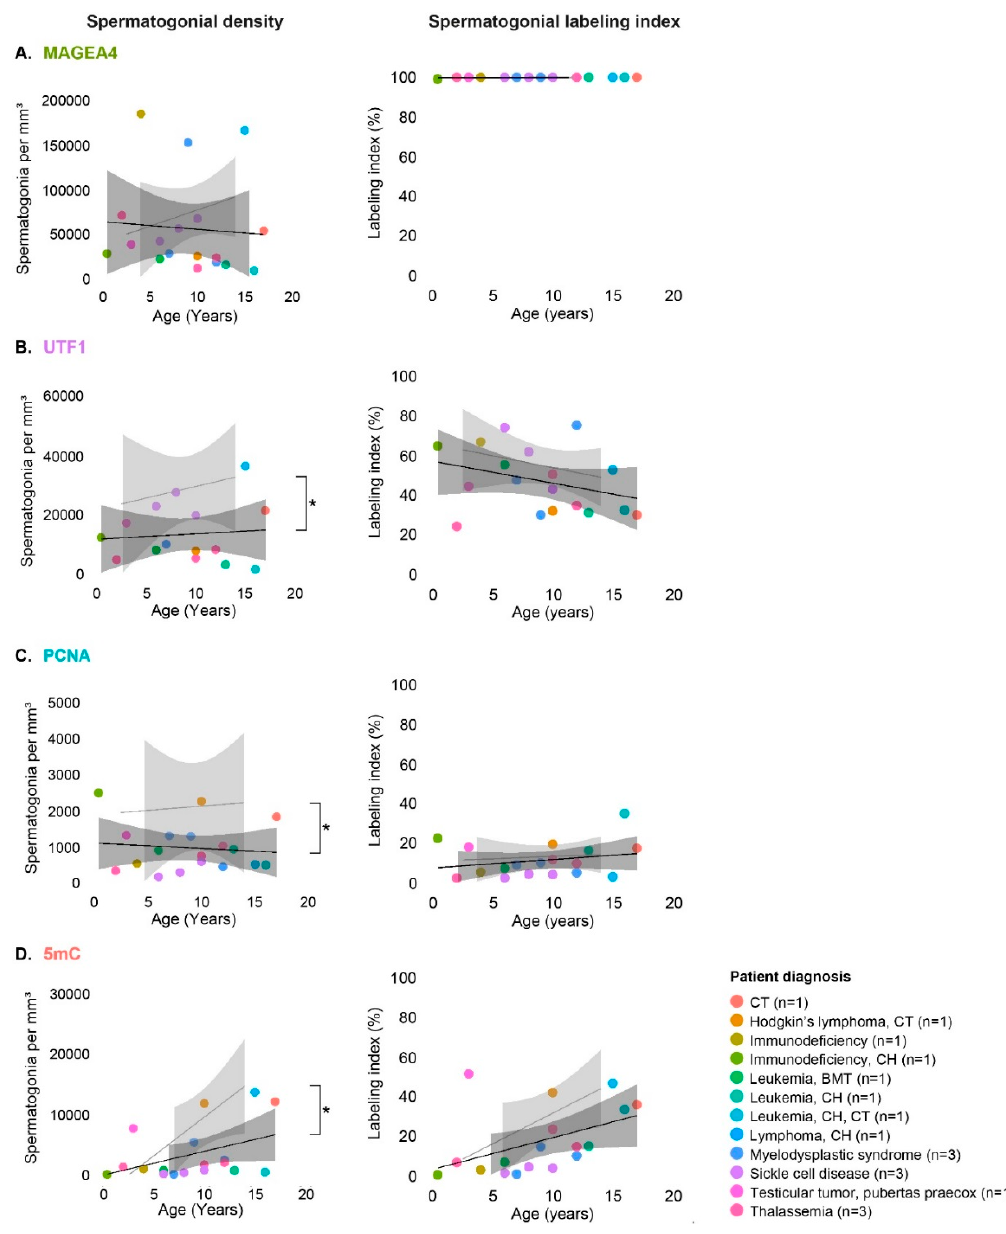
Figure 4. Spermatogonial density and labeling indices (%) of patients with potentially affected tissue by disease and / or treatment (AT group) compared with established values during normal testicular development (NT group). ( A ) MAGEA4, ( B ) UTF1, ( C ) PCNA, and ( D ) 5mC labeling index. Results for each AT patient are represented with individual dots colored according to diagnosis. Previously established reference values throughout age (NT group) are represented as light-gray area (95% confidence interval). Wilcoxon rank-sum test was used to compare labeling indices of the AT group with the reference during testicular development. Statistically significant difference is represented as * p < 0.05. Abbreviations: CT—cryptorchid testes; CH—chemotherapy; BMT—bone marrow transplantation.